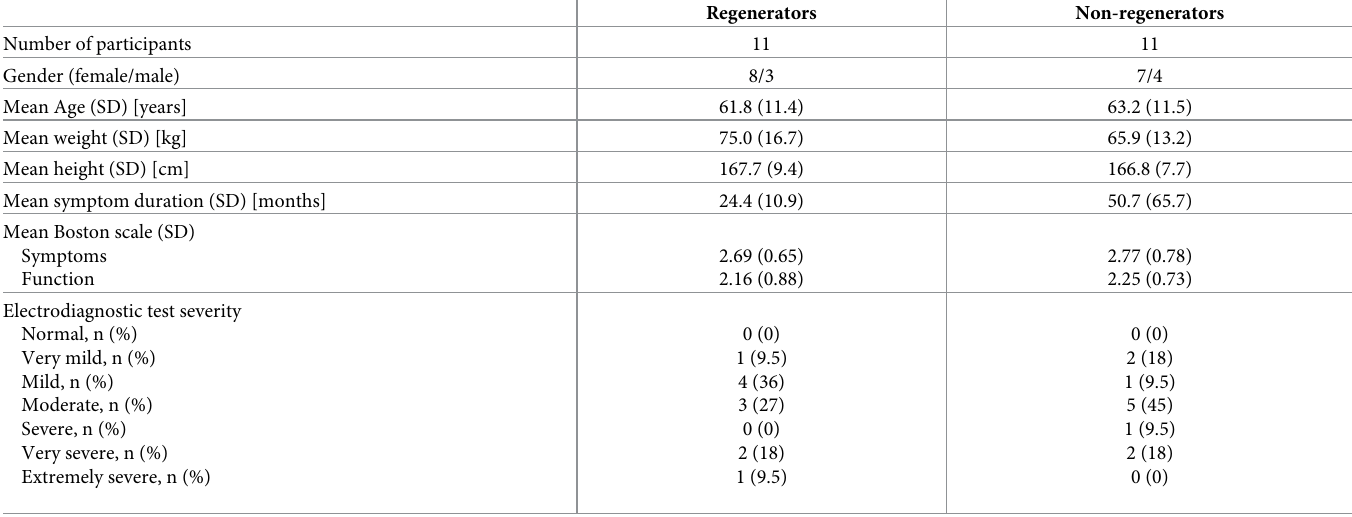
p = 0.021, Wilcoxon p = 0.498, Fig 1A). However, when correcting for the total number of axons, there was no difference in the per- centage of PGP+ IENF containing GAP-43 among groups (median [IQR] healthy 7.96% [23.54%], CTS pre 13.1% [26.9%], CTS post 14.6% [41.2%], Mann Whitney p = 0.872, Wil- coxon p = 0.701, Fig 1B). Eleven patients each were classified as regenerators and non-regenerators according to the difference in their PGP+ IENFD post to pre surgery (Fig 1C). These groups had comparable Table 2. Participant characteristics of patients classified as regenerators and